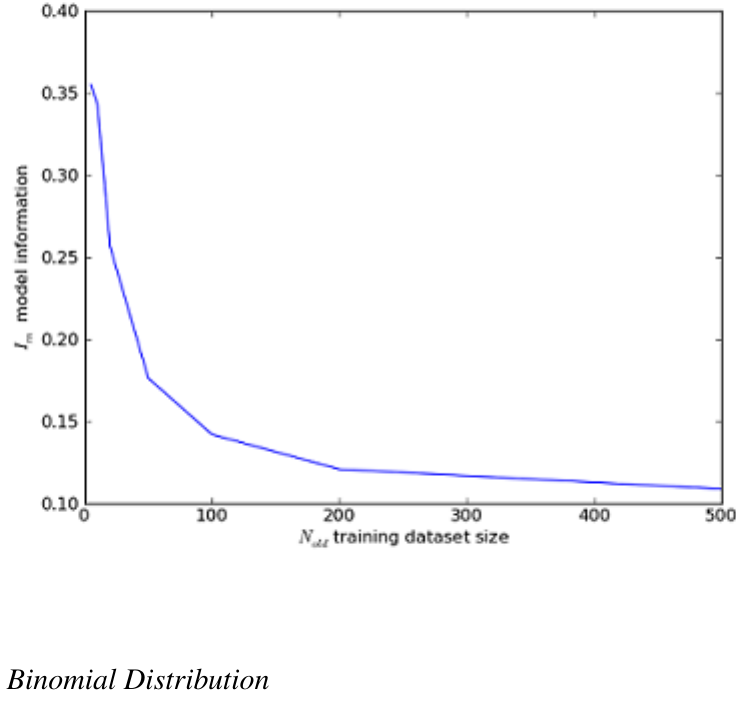
Figure 3. Model information of the normal distribution. A model can exceed the prediction power of the empirical density computed from the training observations, because the model predicts the complete shape of the probability distribution, and how fast the tails will go to zero. Of course, as the training dataset size increases, the training data constitute a more and more accurate competing “model”, and the model information decreases asymptotically. For each dataset size, a sample of that size was drawn from a unit normal distribution, and used to train a normal distribution Ψ based on the sample mean and variance. (Ψ) using a test sample of size 100 drawn from the unit We then computed I m (Ψ) normal. This procedure was repeated 1000 times, to obtain the average of I m for that training dataset